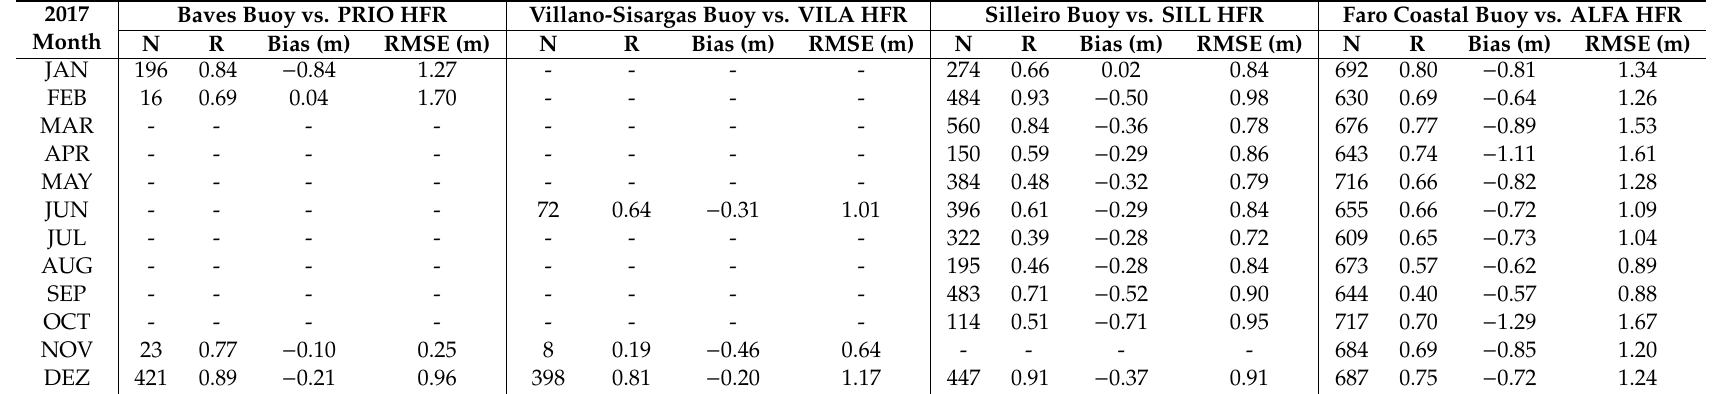
Table A1. Monthly statistics for the SWH comparison between buoys and HFR sites during 2017. Statistics metrics: Correlation coe ffi cient (R), RMSE and bias. N corresponds to HFR & buoy hourly observation pairs. Statistics presented for the four pairs buoy-HFR (Baves vs. PRIO; Villano-Sisargas vs. VILA; Silleiro vs. SILL and Faro coastal vs. ALFA).